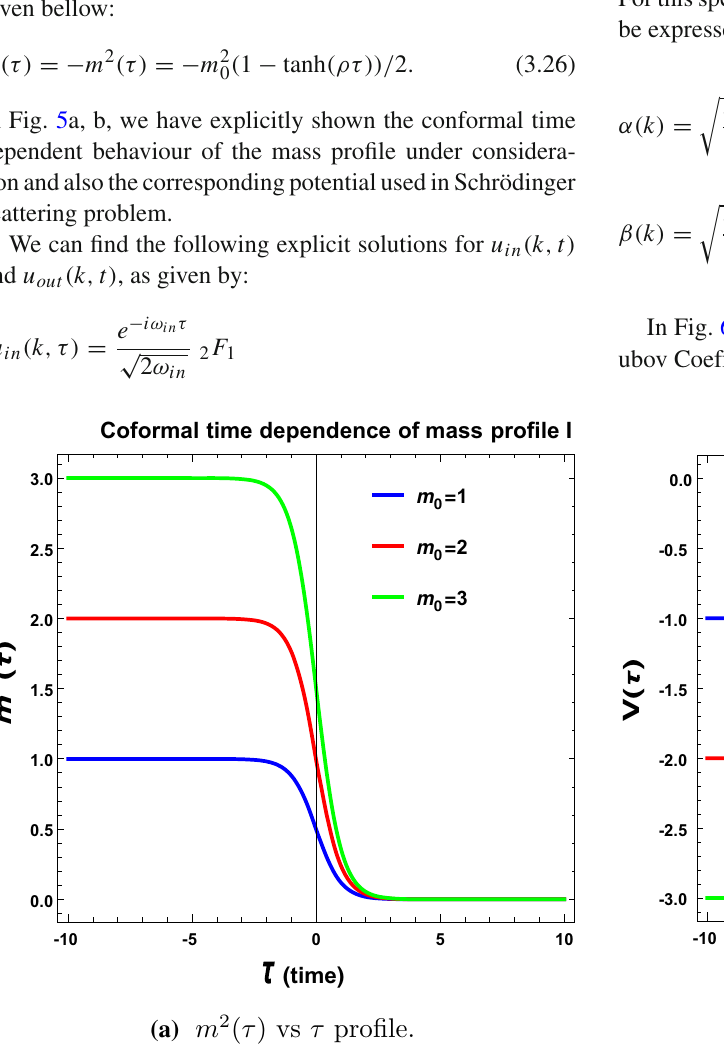
Fig. 5 ConformaltimedependentbehaviourofthemassprofileIanditscorrespondingpotentialusedinSchrödingerscatteringproblemisexplicitly shown here. Here we fix ρ =